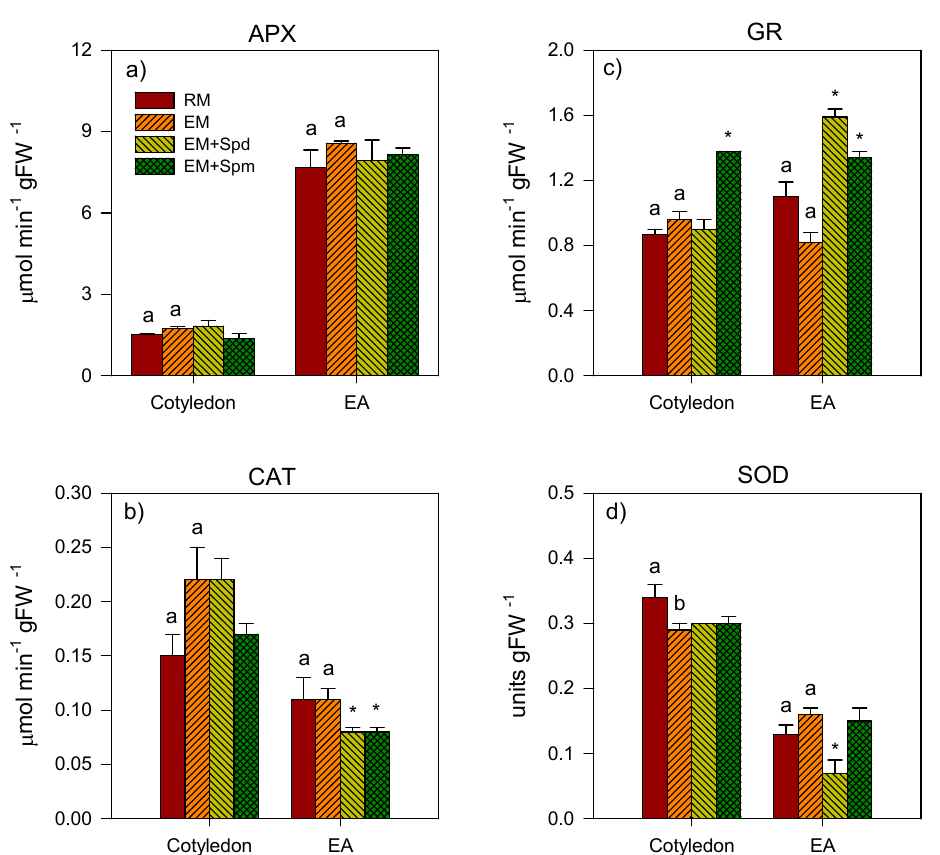
Figure 6. Antioxidative enzyme activity in the tissues of 4 DAP seedlings. Activities of ascorbate peroxidase (APX) ( a ), catalase (CAT) ( b ), glutathione reductase (GR) ( c ) and superoxide dismutase (SOD) ( d ) in the cotyledon and embryonic axis tissues of seedlings under regular watering (RM) and excess moisture (EM) conditions, with or without seed treatment with spermidine (EM + Spd) or spermine (EM + Spm). Data are the means ± SE, n = 2 to 3. Di ff erent letters indicate significant di ff erences in enzyme activity between the RM and EM while asterisks (*) indicate significant di ff erence between the EM and EM + Spd or EM + Spm, p ≤ 0.05.